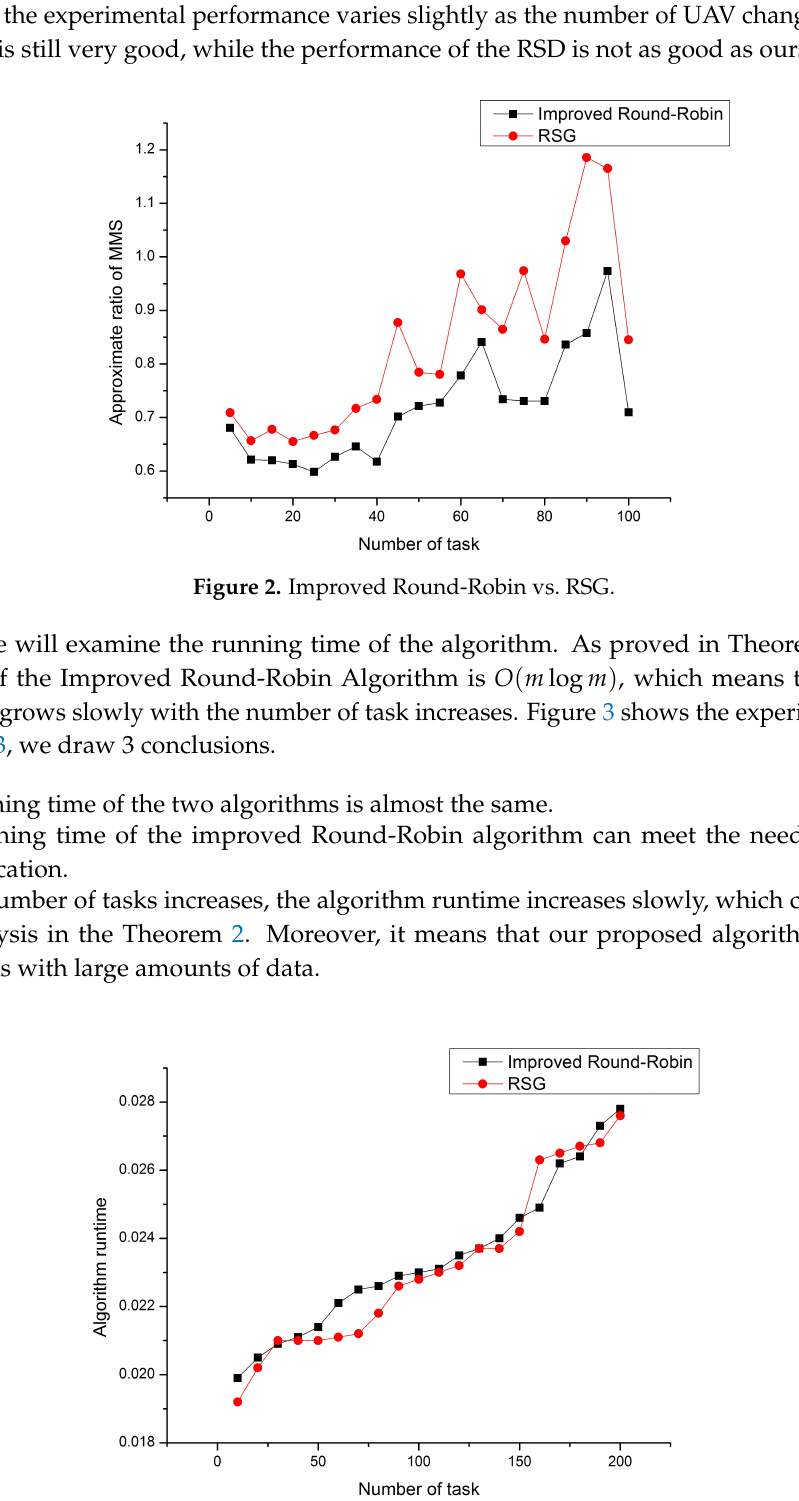
Figure 3. Improved Round-Robin vs.